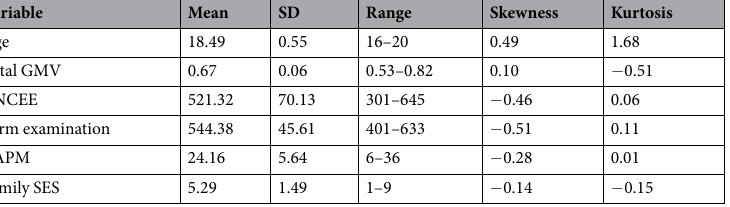
Table 1. Descriptive statistics of participant-level variables. Note: SD = standard deviation; GMV = gray matter volume; CNCEE = Chinese National College Entrance Examination; RAPM = Raven’s Advanced Progressive Matrix; SES = socioeconomic status. The values of term examination were based on 129 participants, other values were based on 214